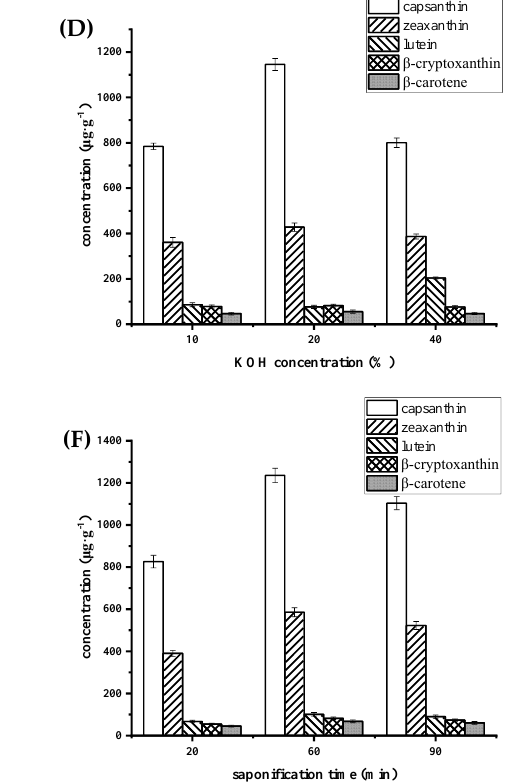
Figure 2. Concentrations of capsanthin, zeaxanthin, lutein, β -cryptoxanthin and β -carotene under different extraction conditions ( A ) extraction solvent, ( B ) ultrasonic time, ( C ) ultrasonic temperature, ( D ) KOH concentration, ( E ) saponification temperature, ( F ) saponification time.